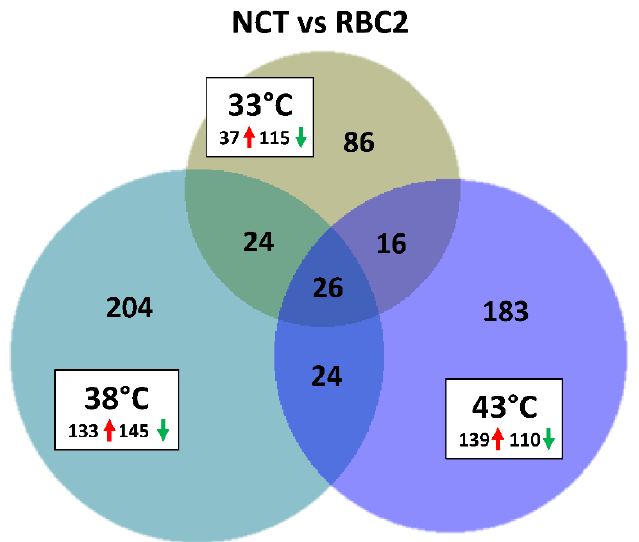
Figure 7. Distribution of differentially expressed genes between lines (NCT vs. RBC2) during p. major SC differentiation. For each temperature comparison, the number of genes with FDR p -value < 0.05 and |Log 2 FC| > 2.0 that were shared or unique to each incubation temperature are indicated. The number and direction of expression change (red, ↑ up or green, ↓ down) for the genes included in each temperature group are listed outside the Venn diagram. Circle size is proportional to the number of DEGs.